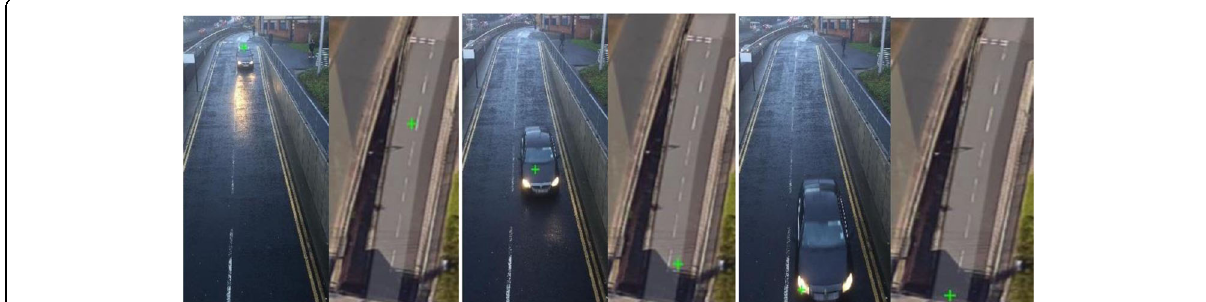
Fig. 18 Homographic computation of vehicle on video and map